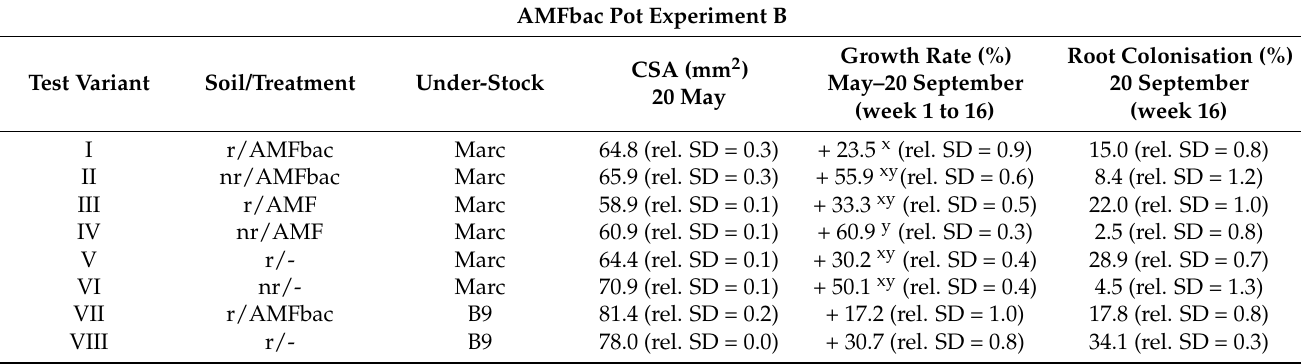
Table 10. AMFbac Pot Experiment B-Growth rate of CSA and degree of mycorrhizal root colonization.